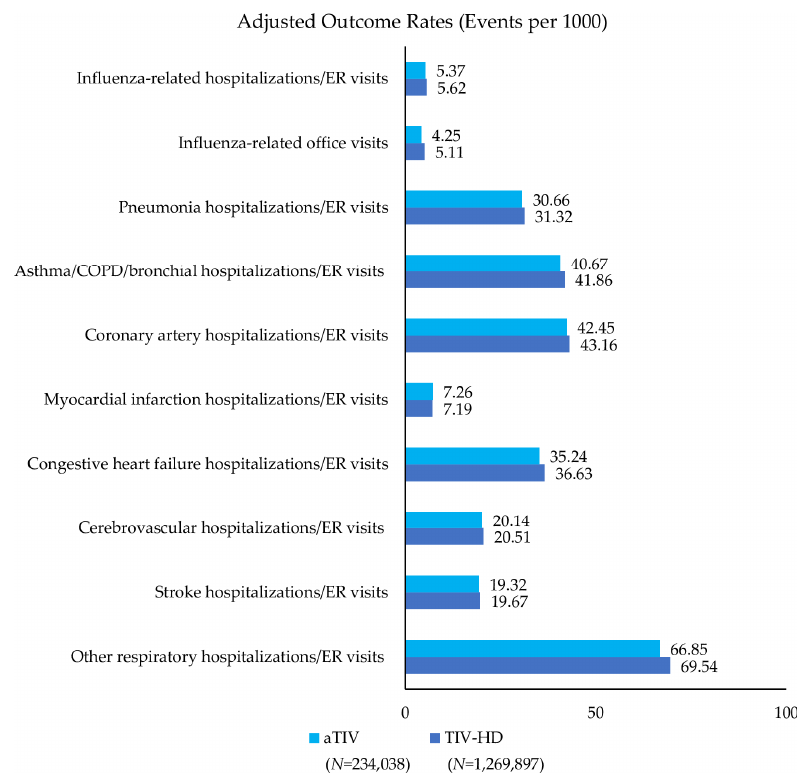
Figure 2. Adjusted outcome rates — post-IPTW — adjuvanted trivalent influenza vaccine (aTIV) vs. high-dose trivalent influenza vaccine (TIV-HD). Rate = events per 1000 vaccinated-subject seasons.